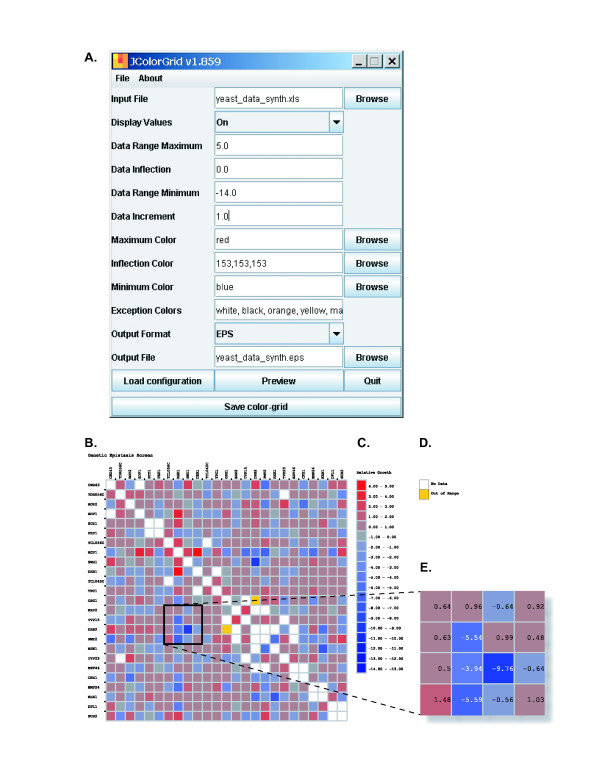
JColorGrid parameters and graphical output. A. The JColorGrid graphical configuration menu or text configuration files (not shown) allow users to create custom color-grids. The configuration shown was used to generate the color-grid shown in B., where synthetic lethal genetic interactions are shown in blue, suppressor interactions in red, and non-interactions in light gray. The color-grid output includes a color scale (C.) and exceptions key (D.). JColorGrid can be configured to either hide data values (B.), or display data values (E.) in the color-grid cells.